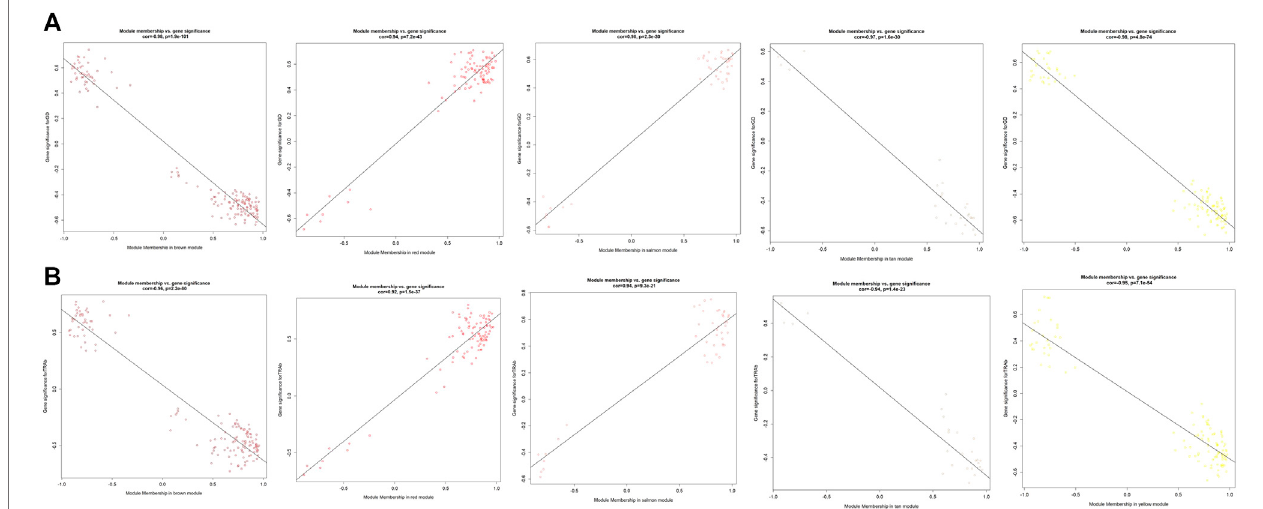
FIGURE 6 | The scatterplots of different modules highly related to GD and TRAb. (A) GD; (B) TRAb. The correlation coef fi cient and p value ofmodule membership vs. gene signi fi cance were shown.